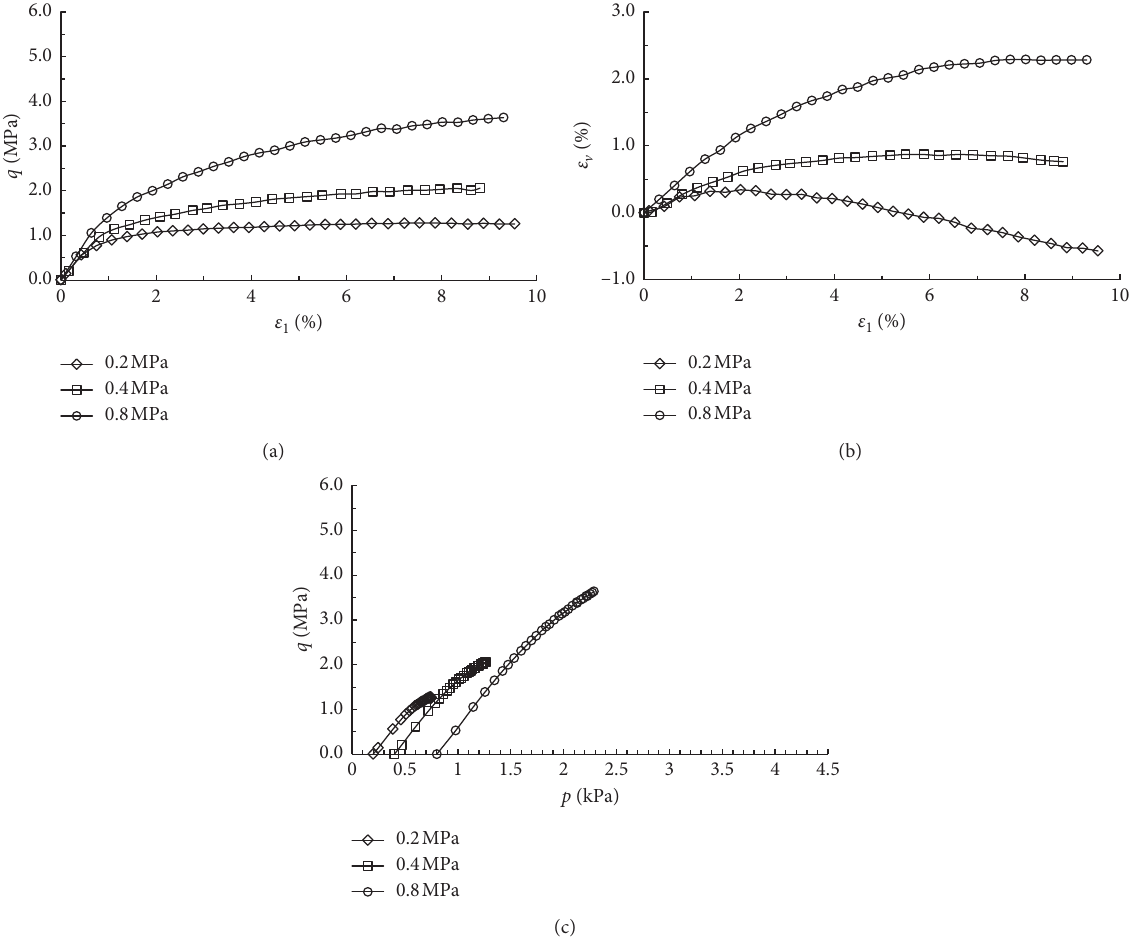
Figure 10: The results of the plane strain test: (a) stress-strain curves; (b) volumetric strain curves; (c) stress paths.